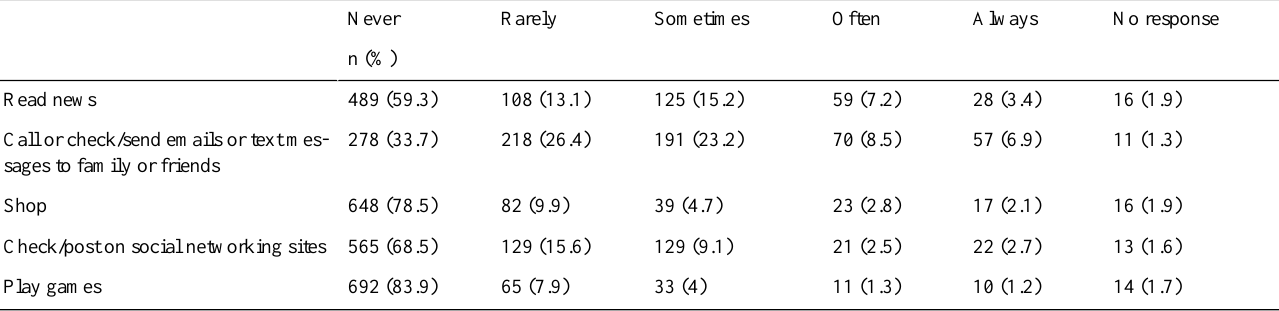
Table 2. Number of study respondents who answered the question, “On an average workday, describe your use of your personal mobile phone or other communication device (excluding breaks and meal times)?”